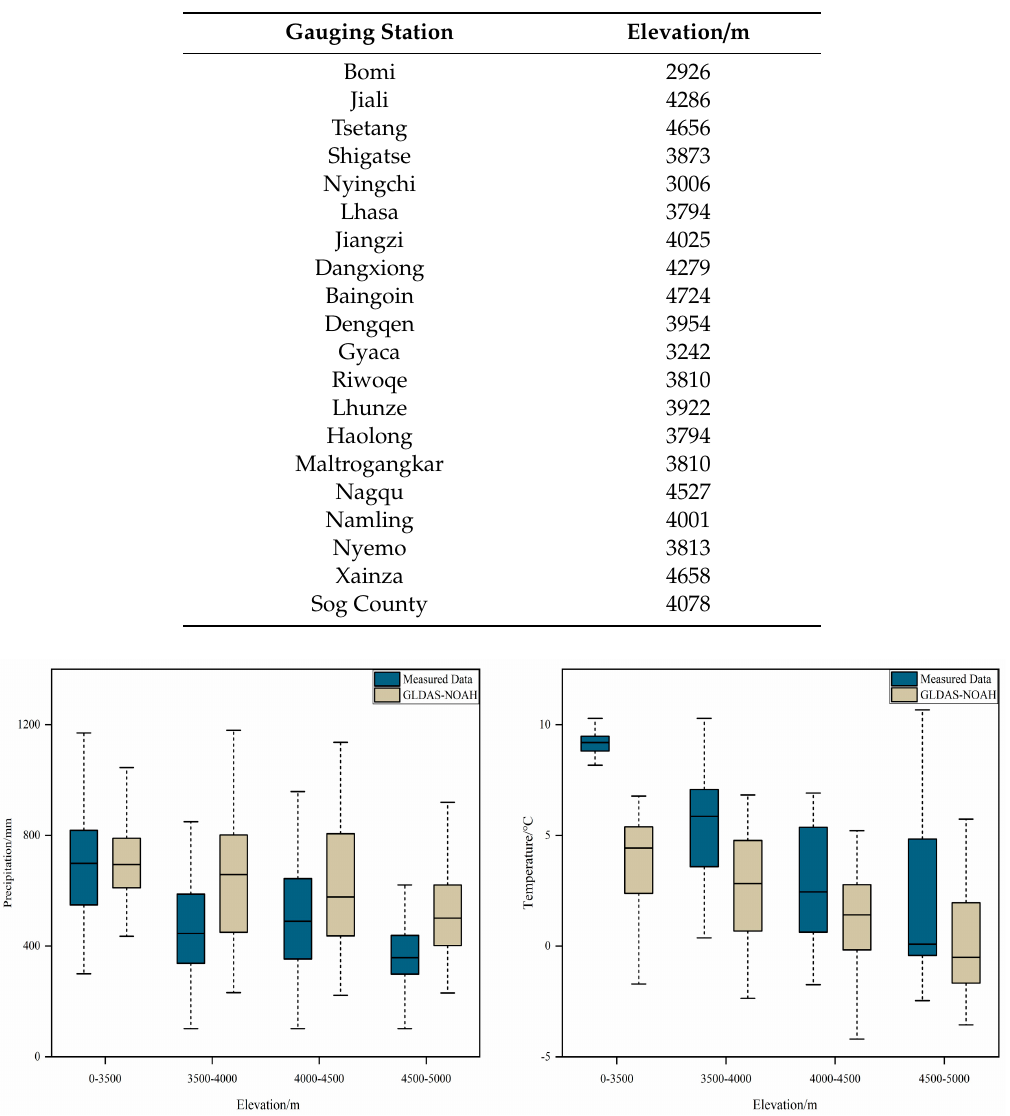
Table 4. Elevations of the 20 gauging stations.